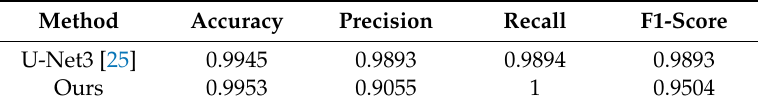
Table 3. Comparison of human detection result in our method and U-Net3 on the TVHeads dataset, according to the evaluation criteria in